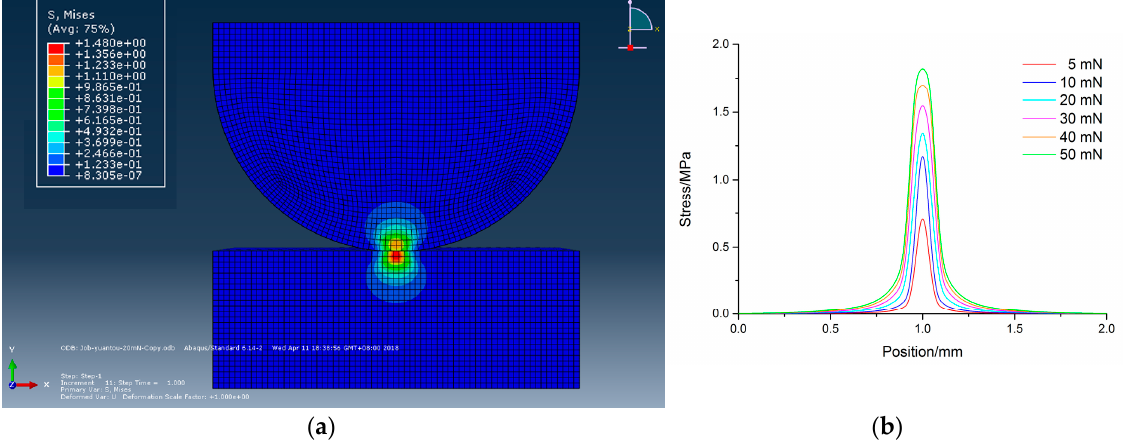
Figure 2. Stress distribution w/o tool wear ( a ) cross-sectional view at 20 mN, and ( b ) under different loads on workpiece surface.